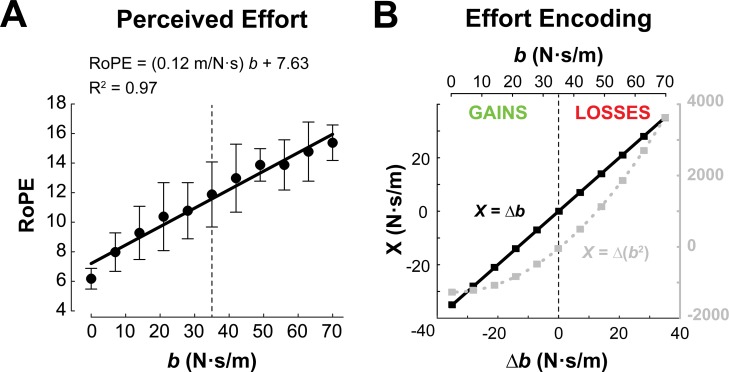
Representations of effort.(A) Mean and standard deviation of perceived exertion (RoPE; from Borg’s Ratings of Perceived Exertion scale), plotted as a function of damping coefficient b. (B) Effort lotteries were encoded as either a linear (black, left axis) or quadratic (gray, right axis) function of the changes in damping coefficient (relative to reference). Dashed lines denote the reference effort condition (35 N⋅s/m) separating gains and losses.